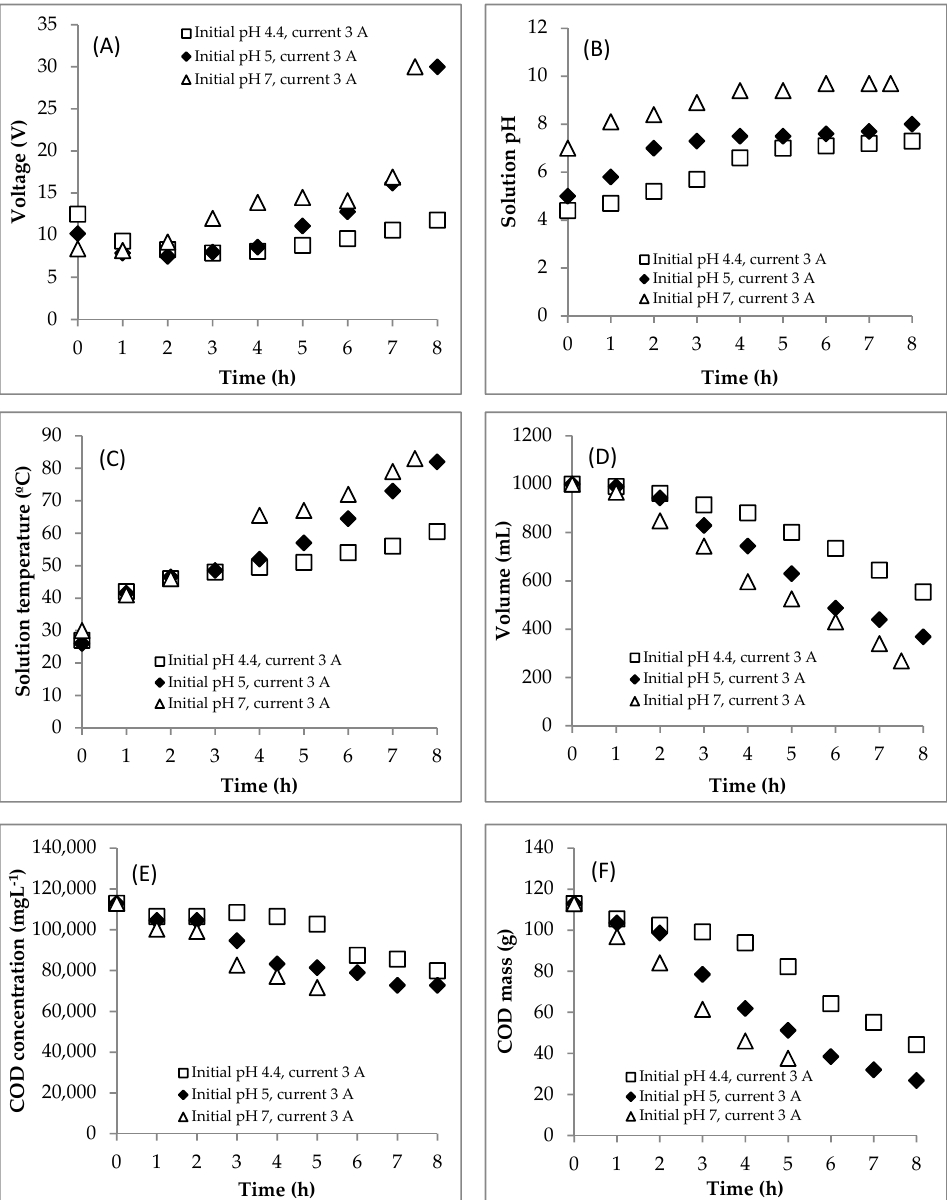
Figure 4. Effect of the initial pH on changes of ( A ) voltage, ( B ) pH, ( C ) temperature, ( D ) volume, ( E ) COD concentration and ( F ) COD mass during the EC process. Initial COD of 112,948.5 mgL − 1 ; constant current of 3 A; initial temperature of 26 – 30 °C.